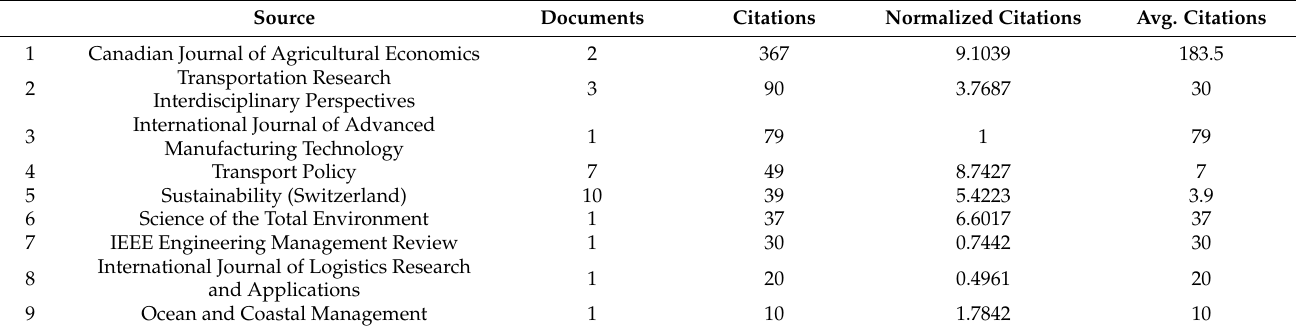
Table 3. Top cited sources.